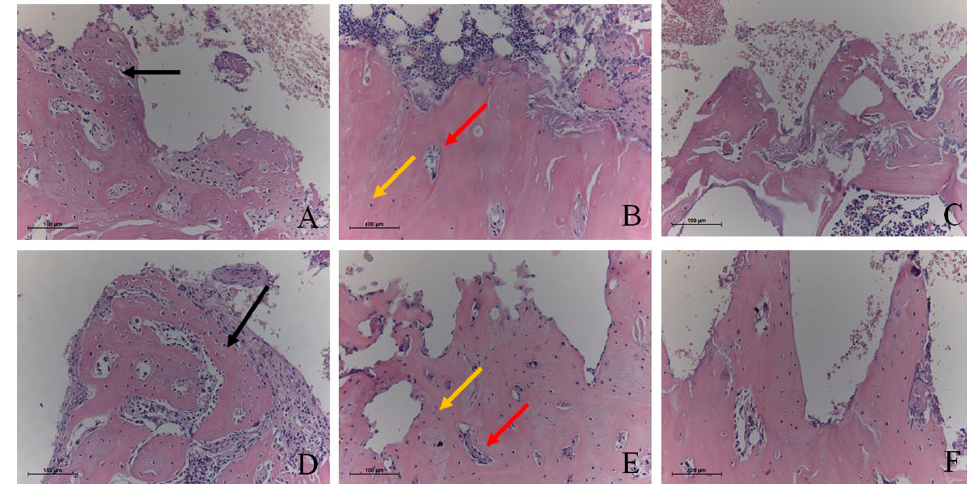
Figure 3- Representative images of decalcified histological sections. A) DBB and DBB-LI groups at 15 days; B) DBB-LIB group at 15 days; C) DBB groups at 45 days; D) HA/TCP and HA/TCP-LI group at 15 days; B) HA/TCP-LIB group at 15 days; C) HA/TCP groups at 45 days. (HE-100x magnification). At 15 days, it was verified that the new bone associated with the biomaterials in the DBB, HA/TCP, DBB-LI, and HA/TCP-LI groups presented an immature bone appearance associated with rounded osteocytes and active osteoblasts (black arrows), the formation of Haversian channels and a large number of new blood vessels (red arrows). The DBB-LIB and HA/TCP- LIB groups showed a more mature appearance, with flattened osteocytes and well-formed Haversian channels (yellow arrows). At 45 days, the presence of mature bone was observed in all groups, with Haversian channels in association with flattened osteocytes and well-established lamellar bone. In all groups and evaluation periods, the presence of biomaterials in contact with the neoformed bone or the connective tissue was